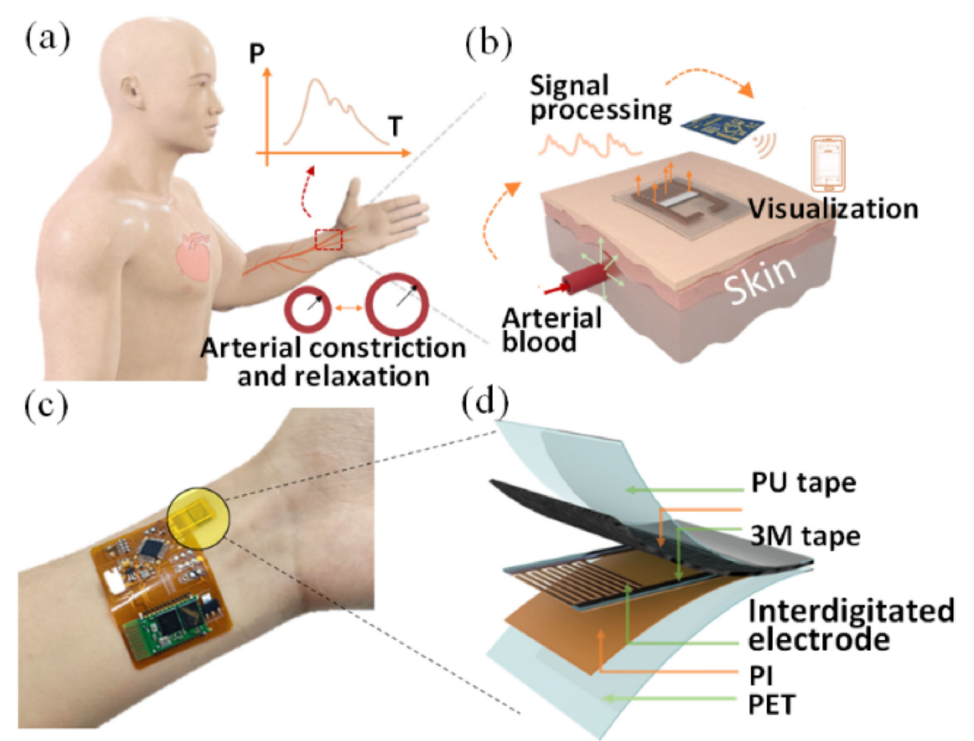
Figure 1. ( a ) The beating of the human heart causes the radial artery vasodilatation and vasodilatation, resulting in a slight pressure change on the skin surface; ( b ) collecting the pressure response signals by flexible sensor and sending signals to the mobile phone for display by a signal processing circuit; ( c ) optical image of the FPS connected with a processing circuit mounted on a participant’s wrist; ( d ) schematic diagram of the structure of